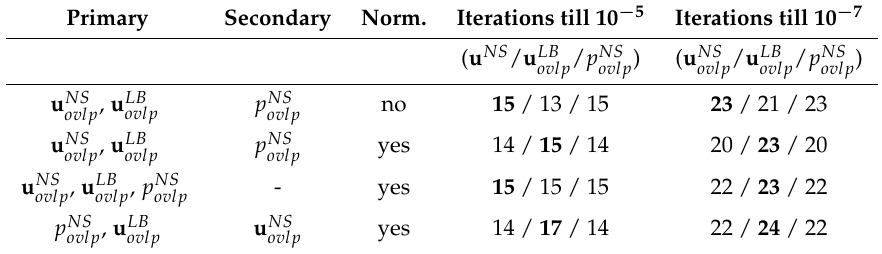
Table 1. Influence of normalization and the choice of primary and secondary variables for the Anderson accelerated coupling. Runs with only one primary coupling variable do not converge. The bold numbers in columns 4,5 correspond to the absolute number of coupling iterations (maximum of the given iteration numbers for each coupling variable) to reach convergence. We use dim( u NS ) = and dim( u LB ovlp